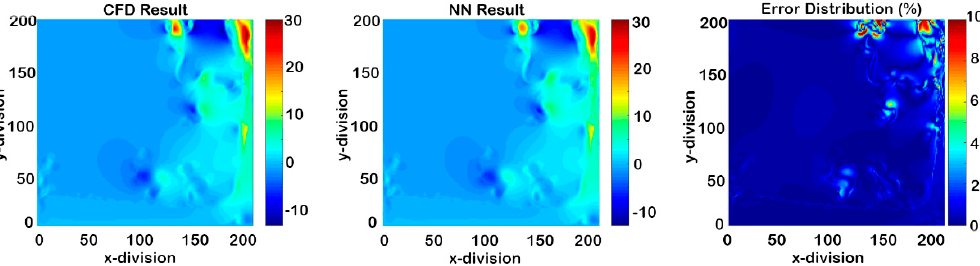
Figure 40. Cascading results of Model IV for Y-direction-velocity at time-step 1050 (50 time-steps after Figure 40. Cascading results of Model Ⅳ for Y-direction-velocity at time-step 1050 (50 time-steps after Figure 40. Cascading results of Model Ⅳ for Y-direction-velocity at time-step 1050 (50 time-steps after deployment). Figure 40. Cascading results of Model Ⅳ for Y-direction-velocity at time-step 1050 (50 time-steps after Figure 40. Cascading results of Model Ⅳ for Y-direction-velocity at time-step 1050 (50 time-steps after deployment). deployment). deployment).